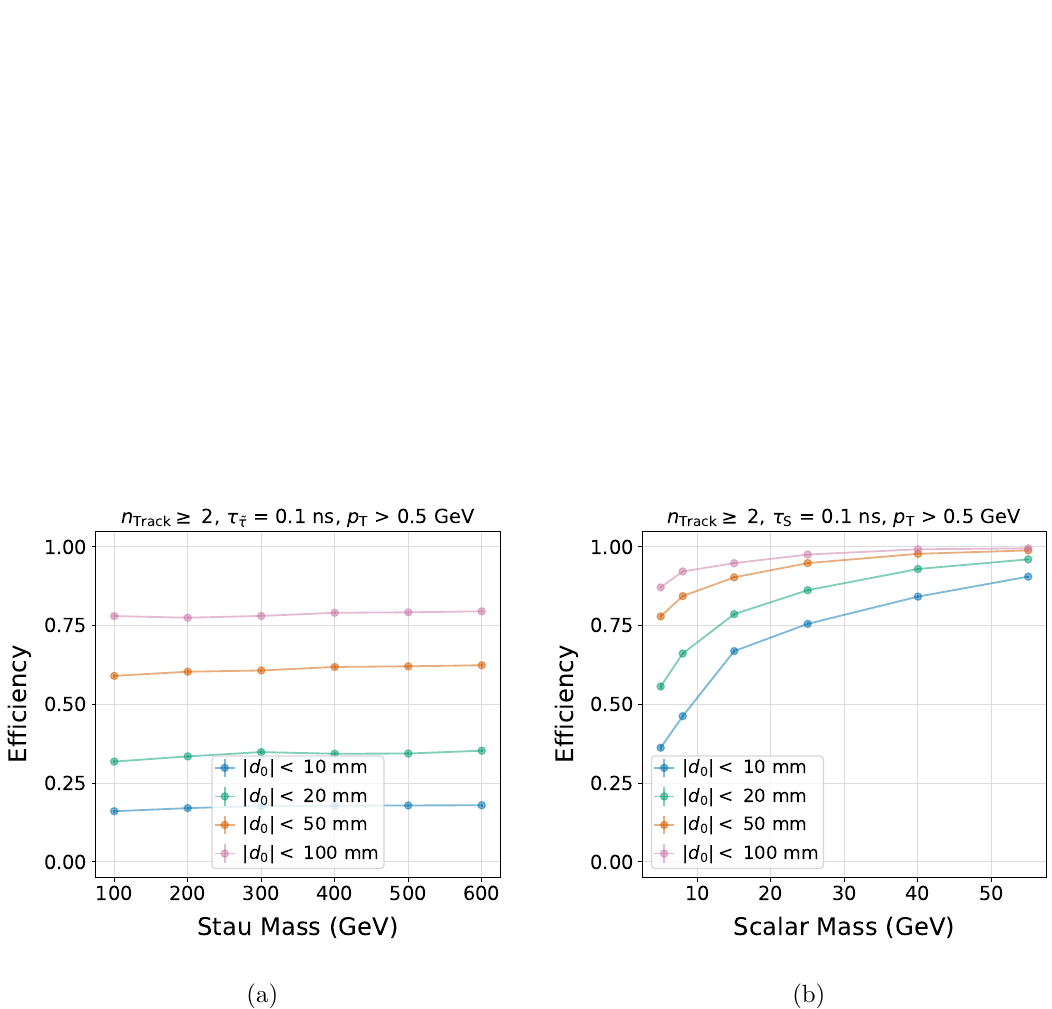
threshold are T 2 Track ≥